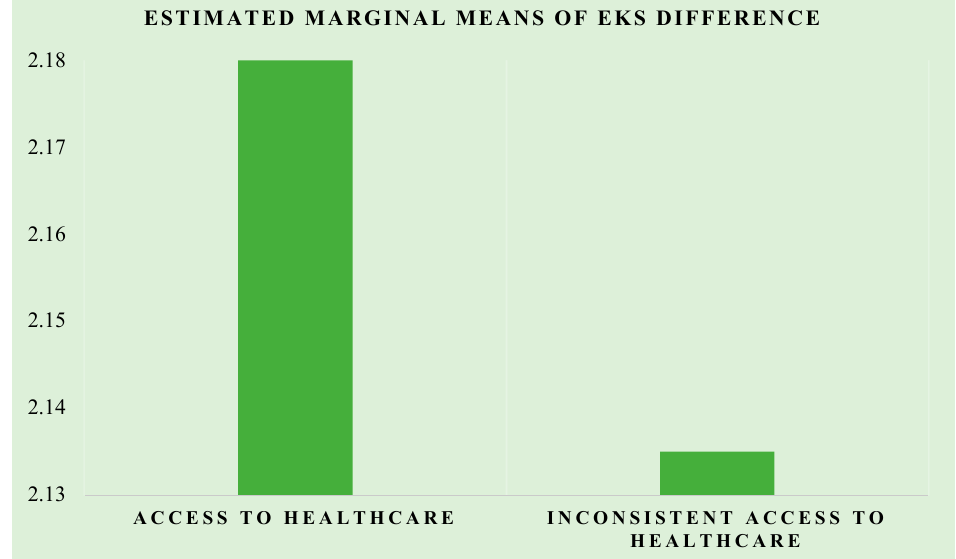
Figure 3. The plot of the estimated marginal means of the difference for the AH and IH groups.